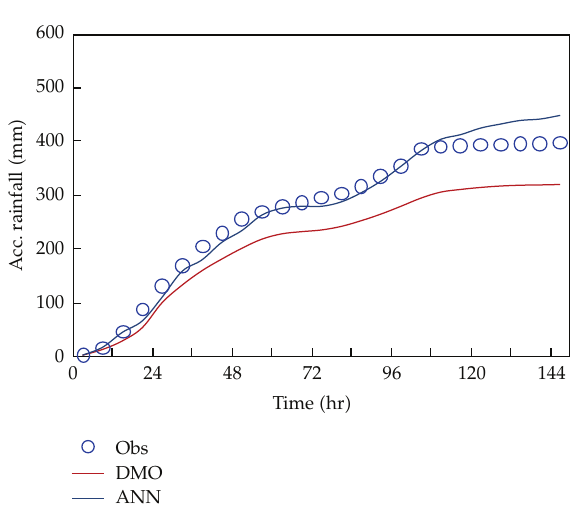
Figure 6: Time series of observed and forecasted hyetographs for the validated storm event on Nov. 1st– 7th, 2009.